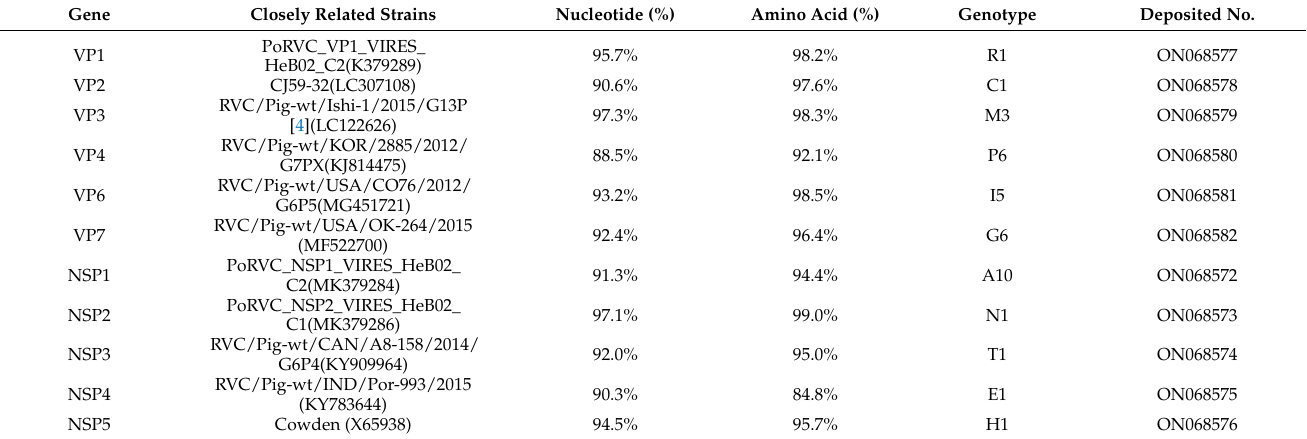
Bank. The VP7 gene contained 1011 nucleotides (nt), encoding 336 amino acids (aa). A